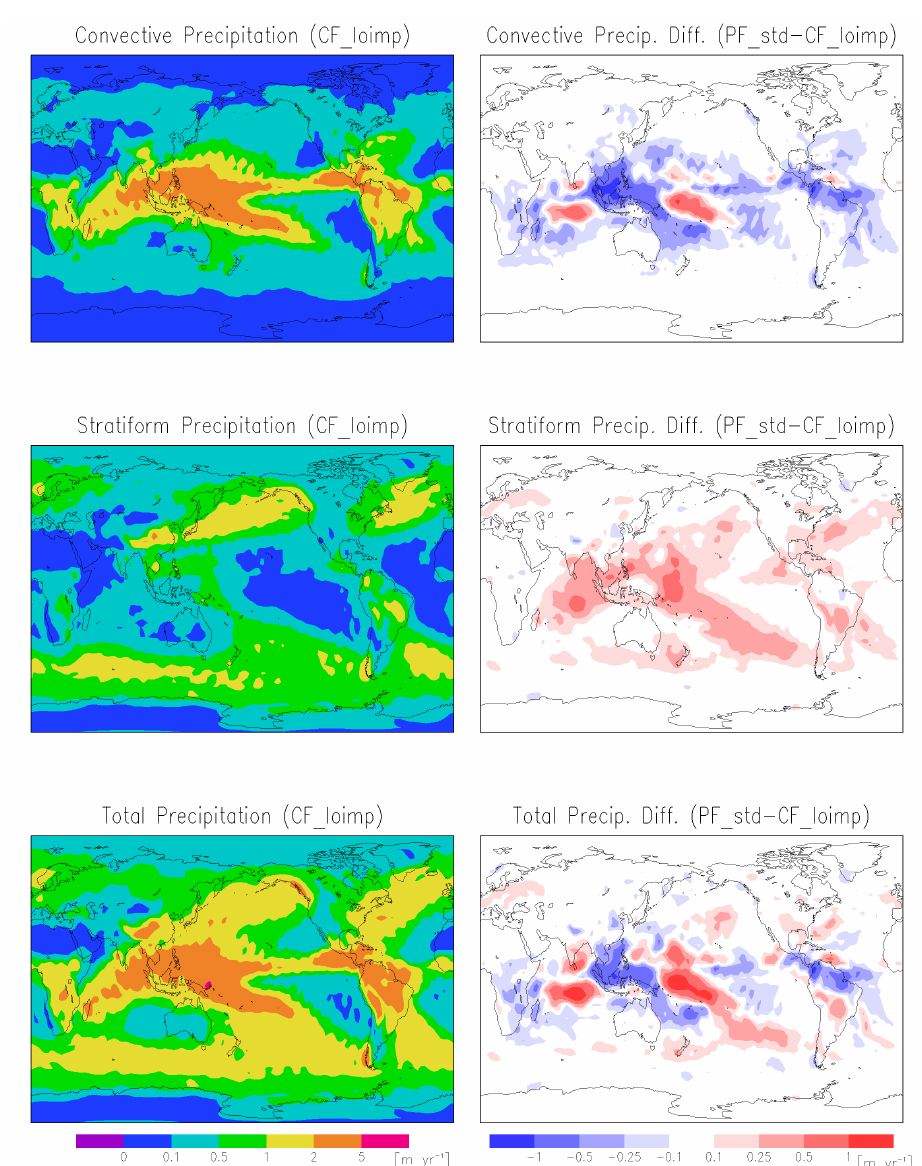
Fig. 5. The geographic distribution of annual mean convective, stratiform and total precipitation for the simulation CF loimp (left panels) and the difference of simulation PF std with respect to CF loimp (right panels). Simulations are described in Table